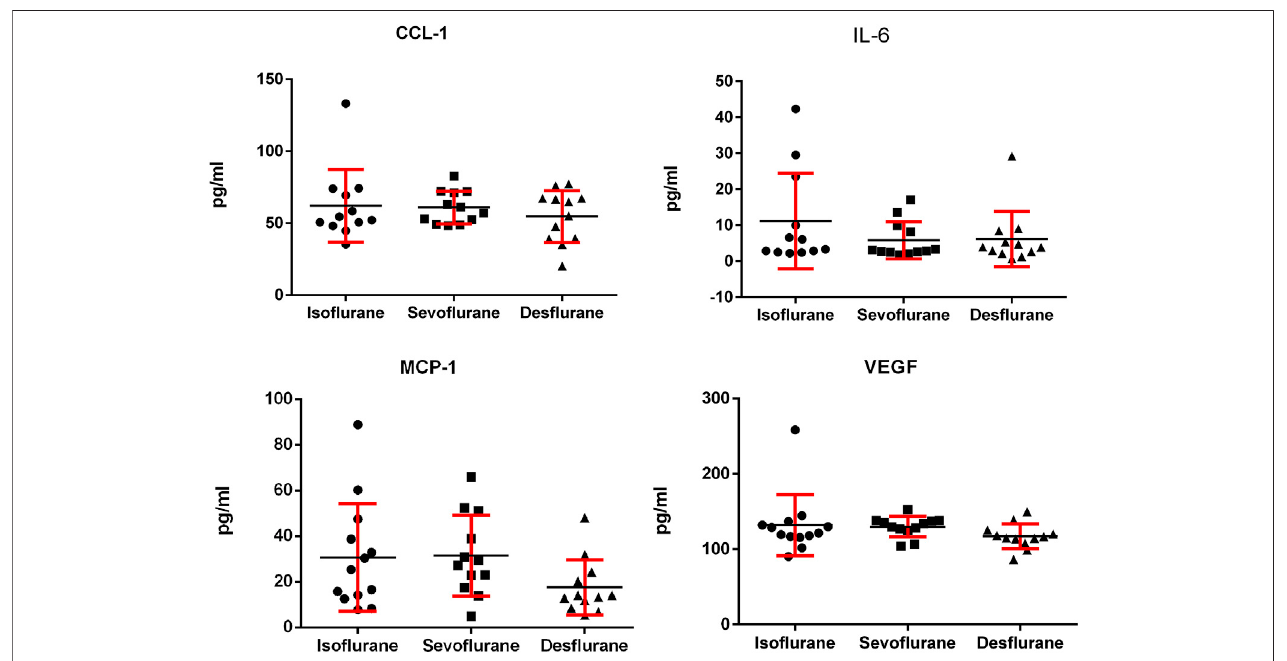
FIGURE 4 | Serum levels of IL-6, MCP-1, CCL-1, and VEGF in the murine 4T1 breast tumor bearing mice 3 weeks following mastectomy with iso fl urane, sevo fl urane, or des fl urane. There was no signi fi cant difference in serum levels of IL-6, MCP-1, CCL-1, and VEGF among 3 groups ( n =12 for iso fl urane group, n = 11 for sevo fl urane group, and n = 11 for des fl urane group; one-way ANOVA + Tukey ’ s multiple comparisons test). IL-6: iso fl urane vs. sevo fl urane, P = 0.508; iso fl urane vs. des fl urane, P = 0.317; sevo fl urane vs. des fl urane, P = 0.445. MCP-1: iso fl urane vs. sevo fl urane P = 0.212; iso fl urane vs. des fl urane, P = 0.134; sevo fl urane vs. des fl urane, P = 0.106. CCL-1: iso fl urane vs. sevo fl urane P = 0.504; iso fl urane vs. des fl urane, P = 0.334; sevo fl urane vs. des fl urane, P = 0.590. VEGF: iso fl urane vs. sevo fl urane, P = 0.354; iso fl urane vs. des fl urane, P = 0.457; sevo fl urane vs. des fl urane, P =